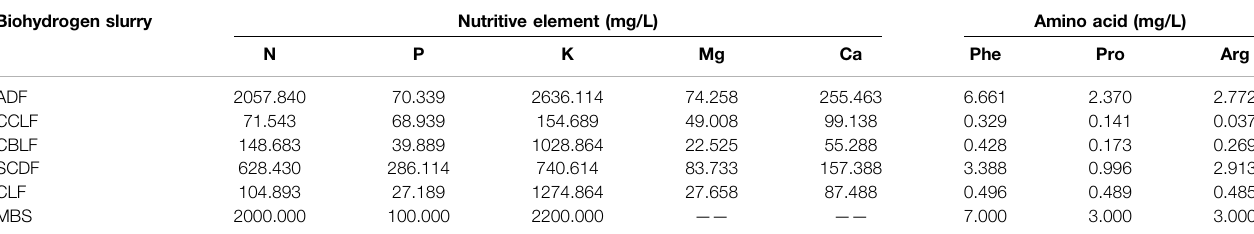
TABLE 1 | Composition of the fi ve biohydrogen slurries. Biohydrogen slurry